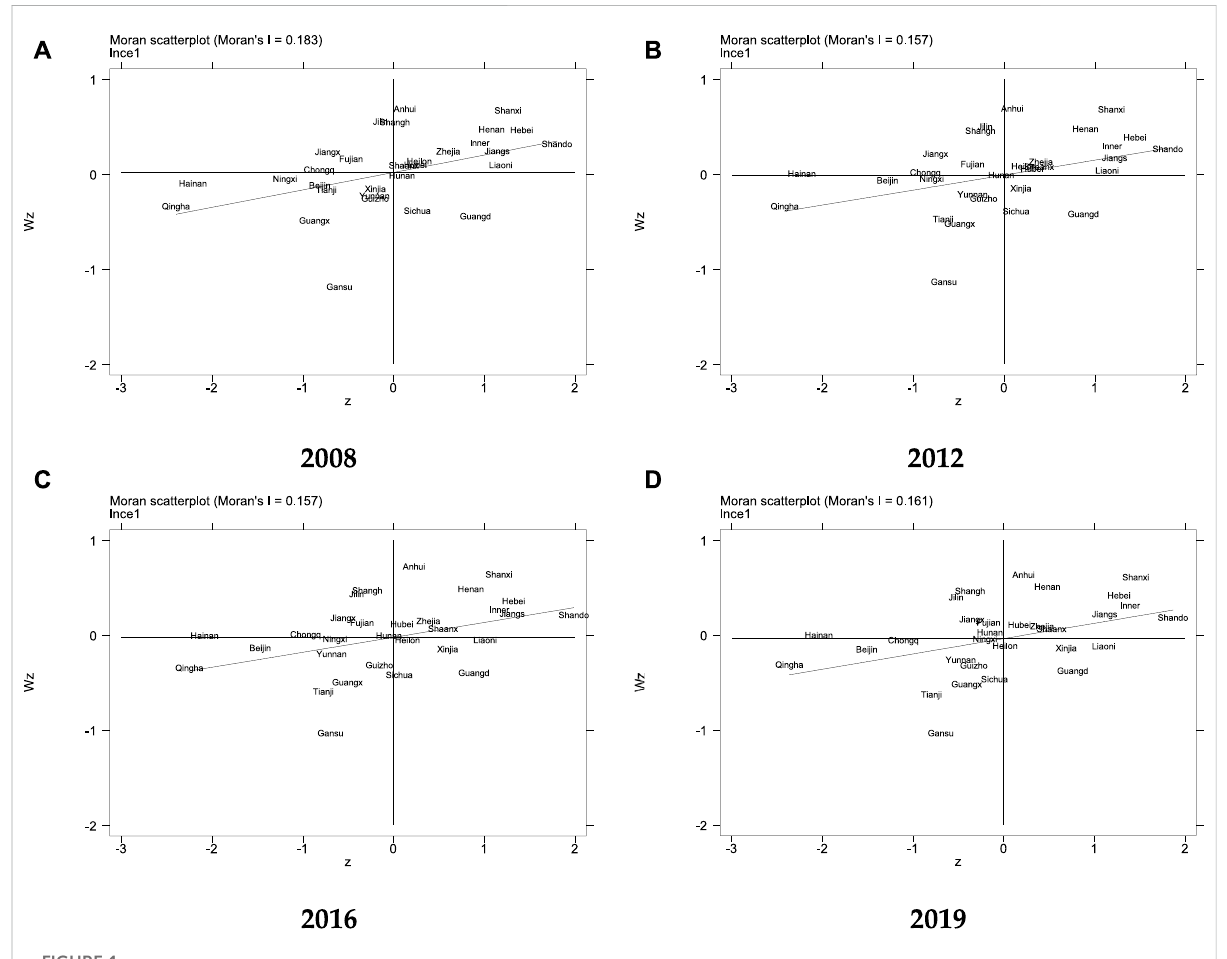
FIGURE 1 (A) Moran ’ I scatter plot of provincial carbon emissions in 2008; (B) Moran ’ I scatter plot of provincial carbon emissions in 2012; (C) Moran ’ I scatter plot of provincial carbon emissions in 2016; (D) Moran ’ I scatter plot of provincial carbon emissions in